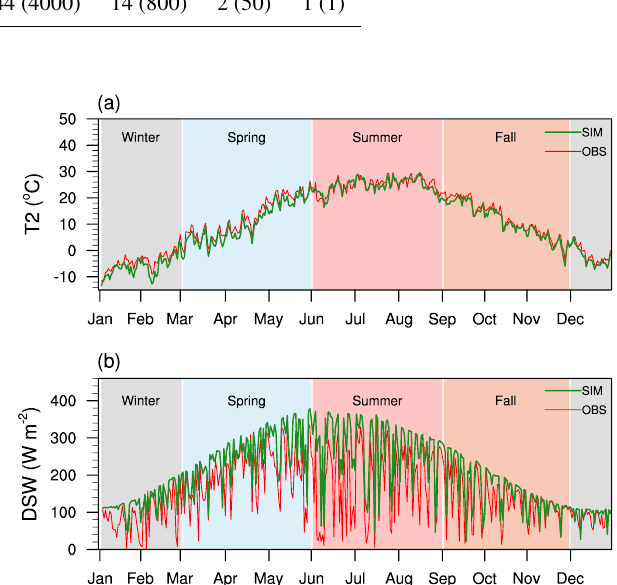
Table 1. Adjusted (original) isoprene emission factors (EF, µgm − 2 h − 1 ) for each plant functional type (PFT). PFT Broadleaf Needleleaf Shrub Grass Other Corn trees trees crops EF 6510 (10000) 64 (600) 544 (4000)